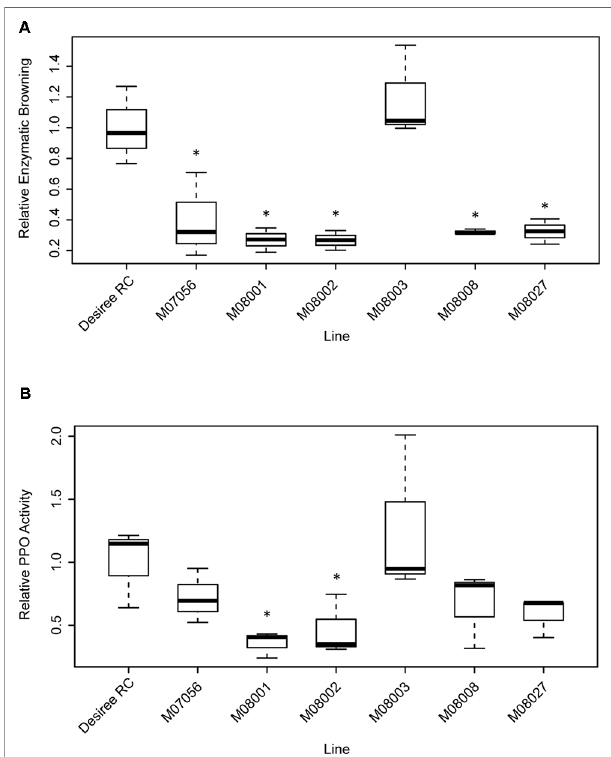
FIGURE 5 | Analysis of Relative Enzymatic Browning (A) and Relative PPO Activity (B) in tubers of selected edited lines. Each box represents data of three biological replicates of the edited lines and the control Desiree RC, the line across the box represents the median. The box represents the 25 th and the 75 th percentiles and whiskers represent the maximum and minimum value. Data are relative to the control line Desiree RC. Statistical differences with the control line Desiree RC are denoted *(p < 0.05).